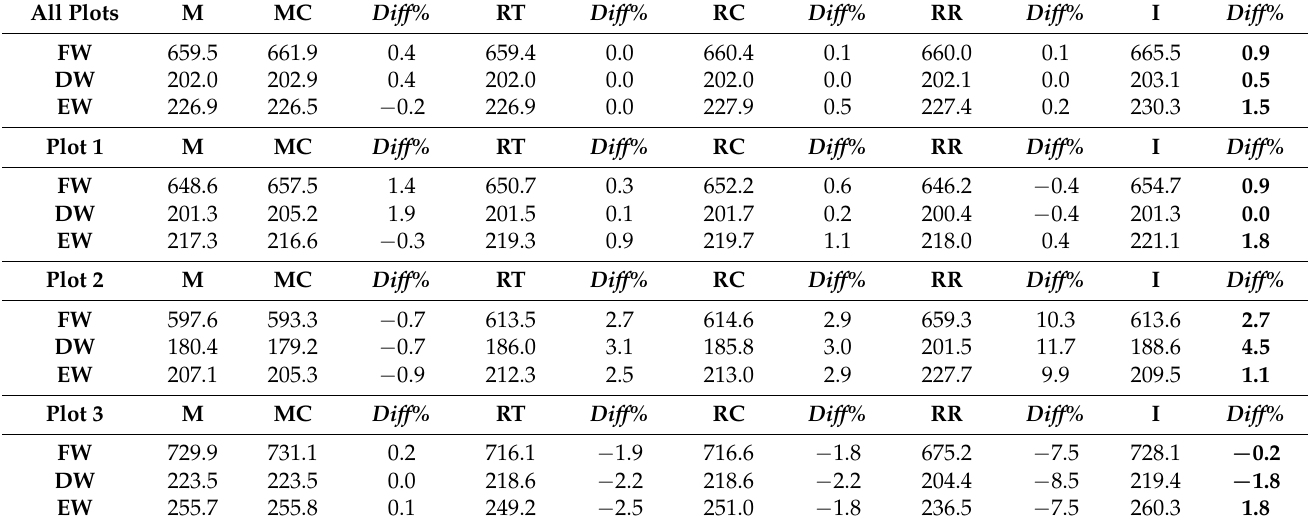
Table 5. Difference (Diff) in mean values (%) between the measured data (all data) ( M ) and the estimated mean values by the other sampling methods: MC, RT, RC, RR, and I, where: M :